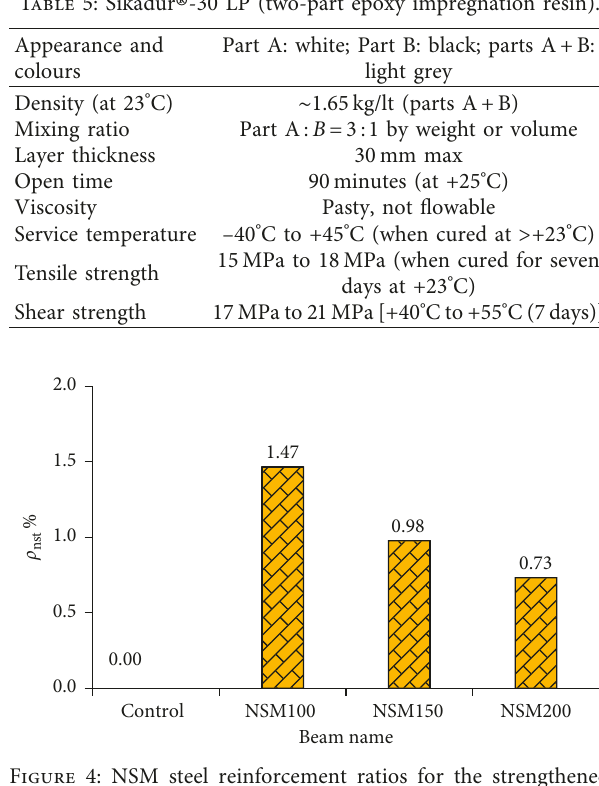
Figure 4: NSM steel reinforcement ratios for the strengthened beams.